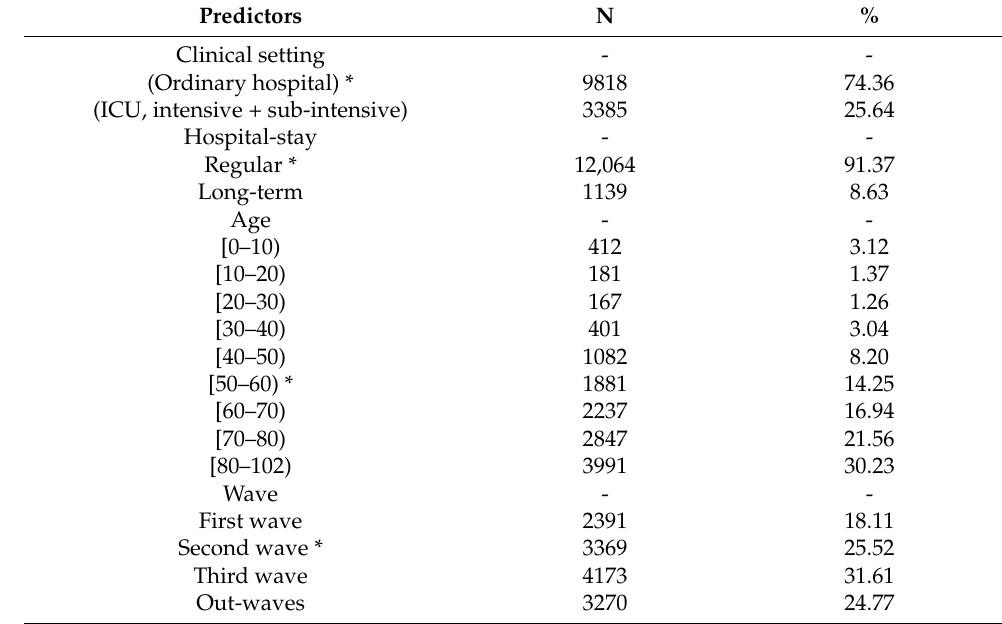
Table 1. Descriptive statistics, frequency, and characteristics of the study sample (N = 13,203).